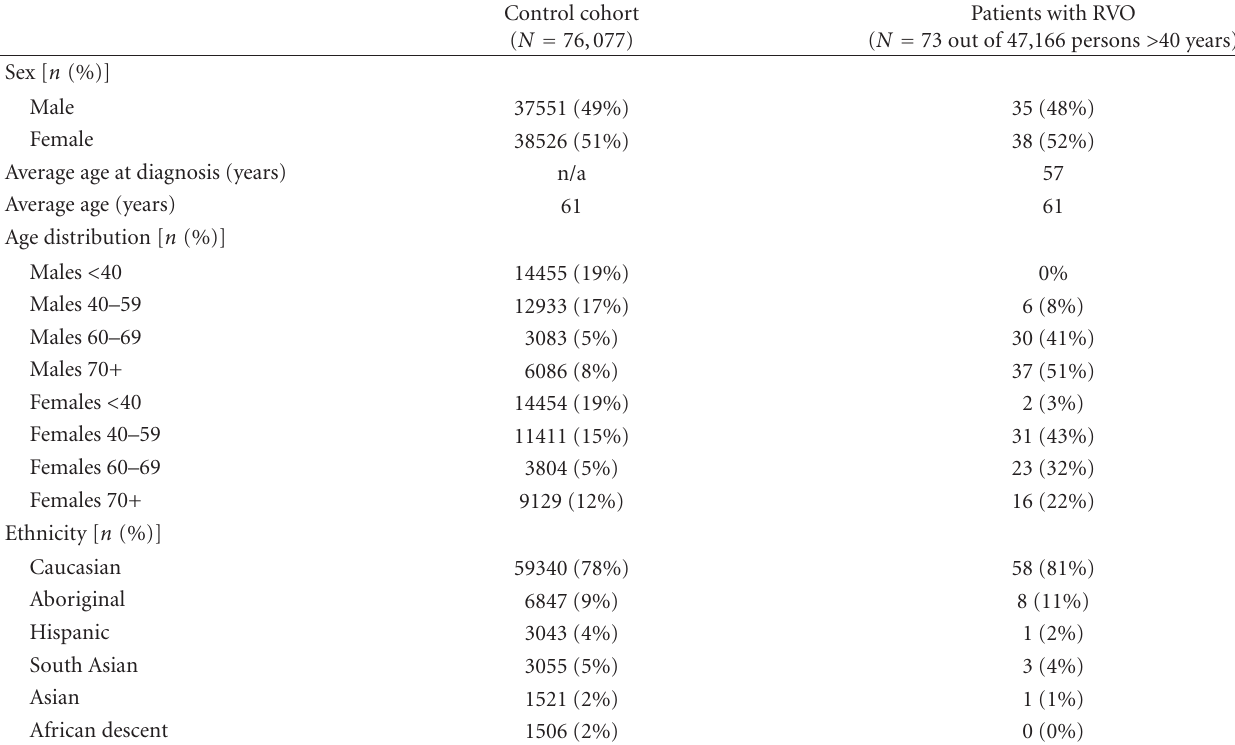
Table 1: RVO in patients across age, sex, and ethnic